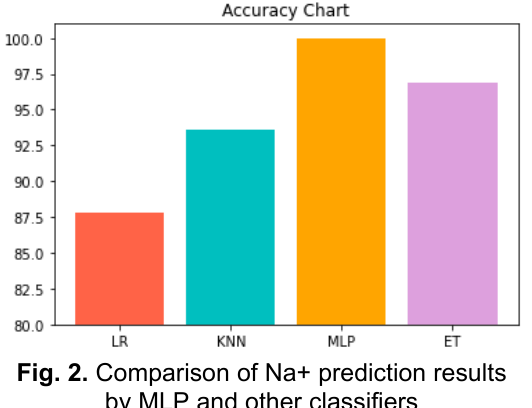
Fig. 2. Comparison of Na+ prediction results